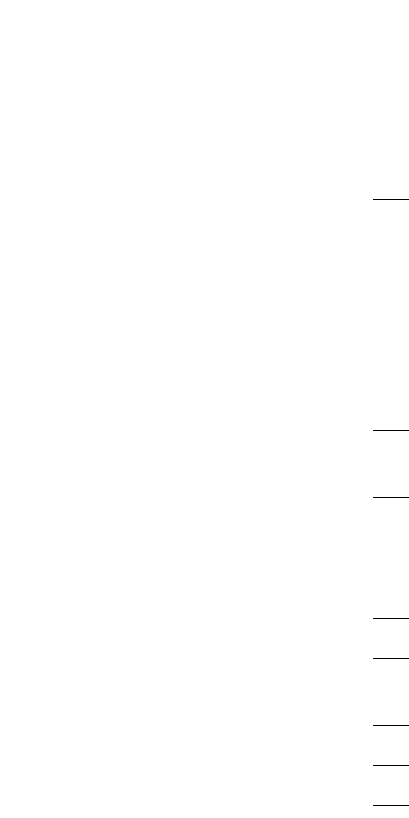
Phytochemical Class Phytochemical Compound Pedicularis